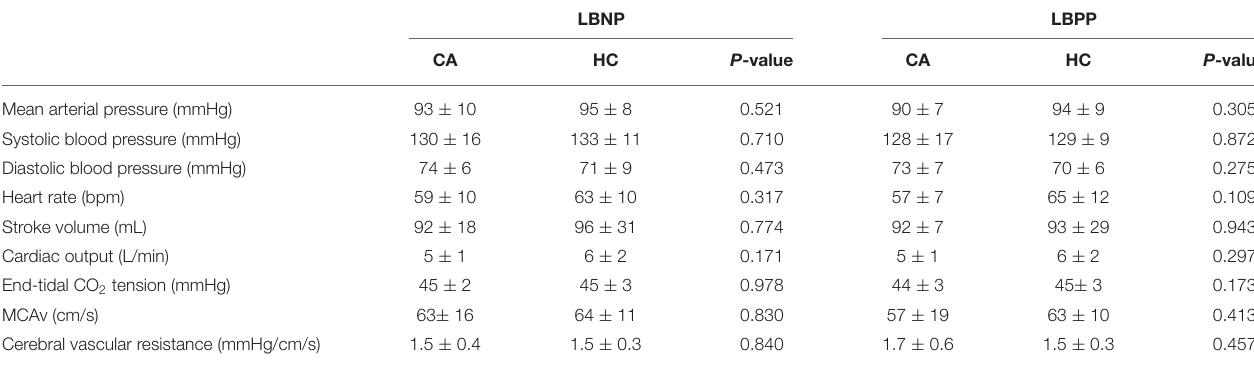
TABLE 1 | Baseline LBNP and LBPP-values for concussed athletes (CA) and healthy controls